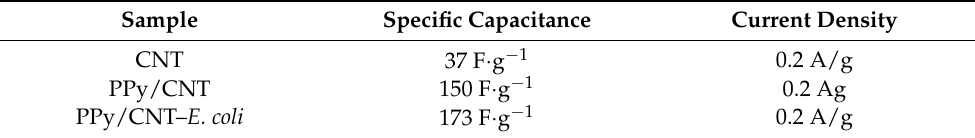
Table 2. Specific capacitance values of CNT, PPy/CNT, and PPy/CNT– E. coli calculated from Galvanostatic charge/discharge (GCD)